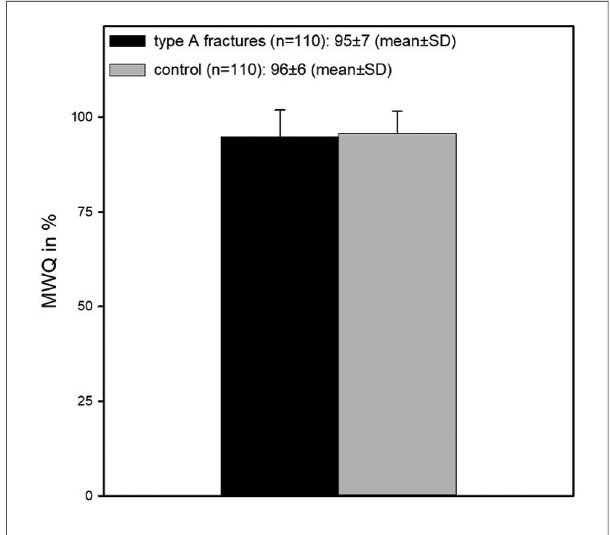
FIGURE 1 This fi gure shows MWQ values for both control and fracture